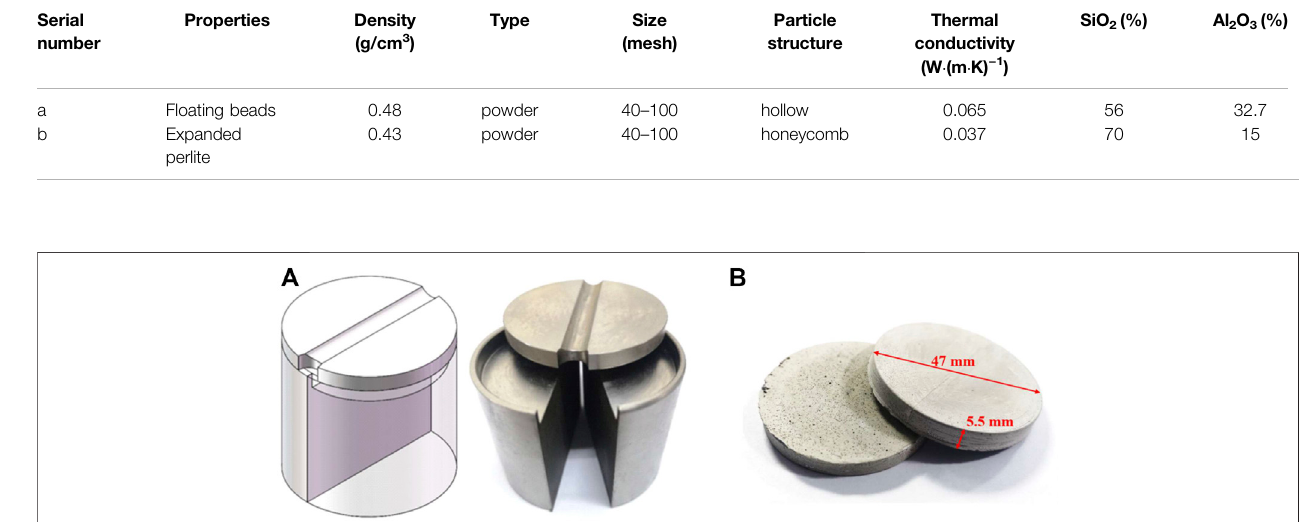
FIGURE 1 | Curing molds and test samples. (A) Curing mold assembly drawing. (B) Thermal conductivity test